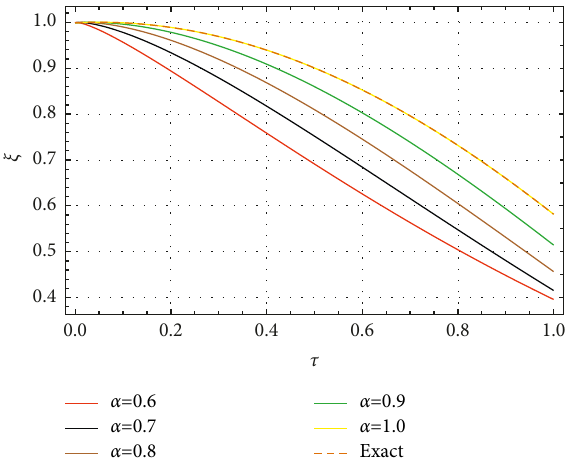
Figure 3: The approximate and exact solutions to the real part of Example 2.